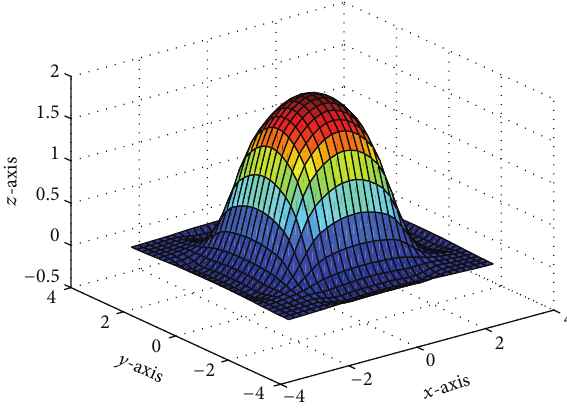
Figure 14: Bicubic Hermite